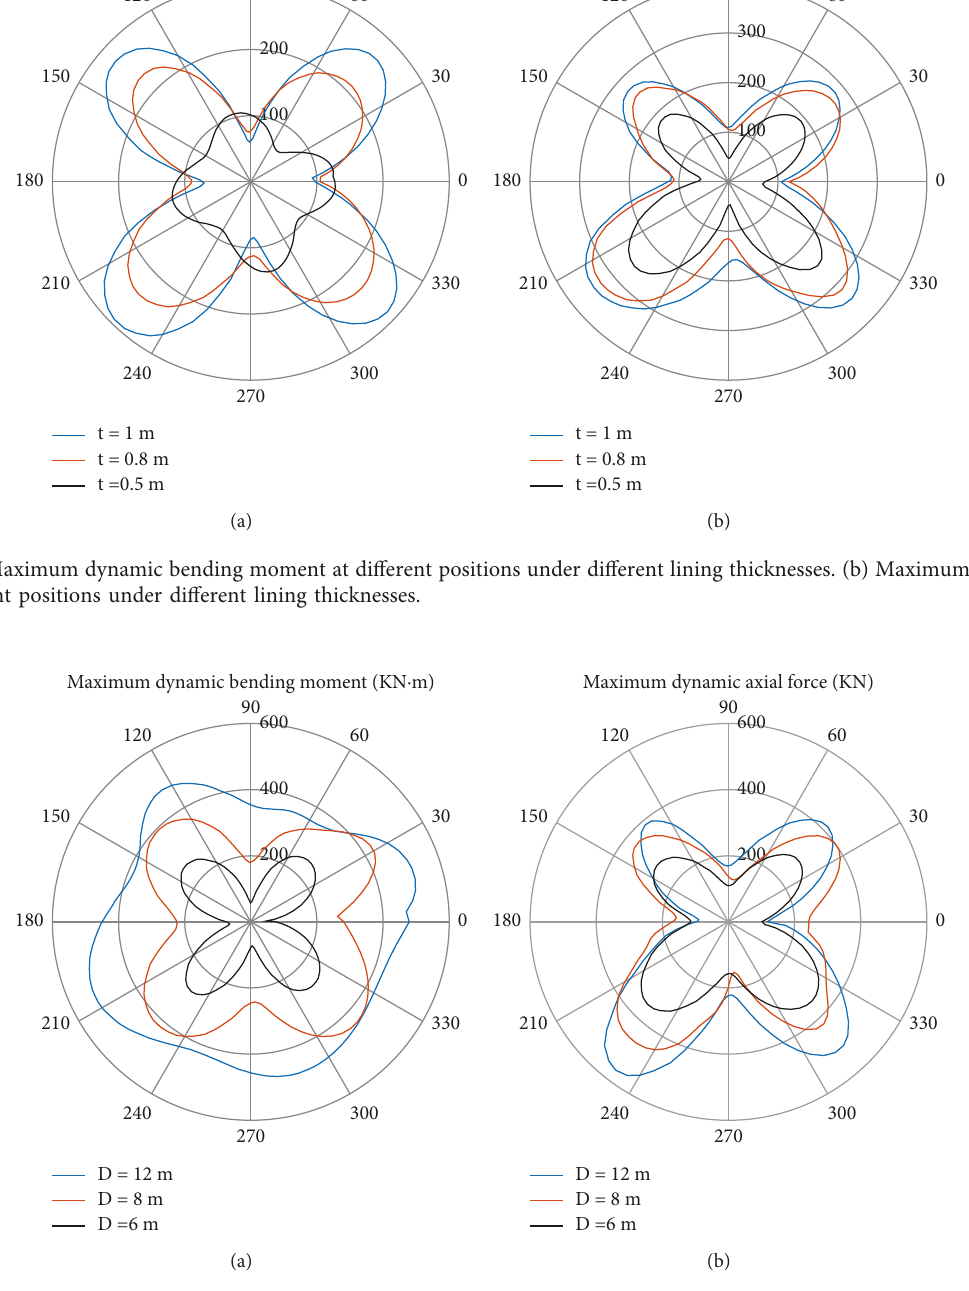
Figure 8: (a) Maximum dynamic bending moment at different positions under different lining diameters. (b) Maximum dynamic axial force at different positions under different lining